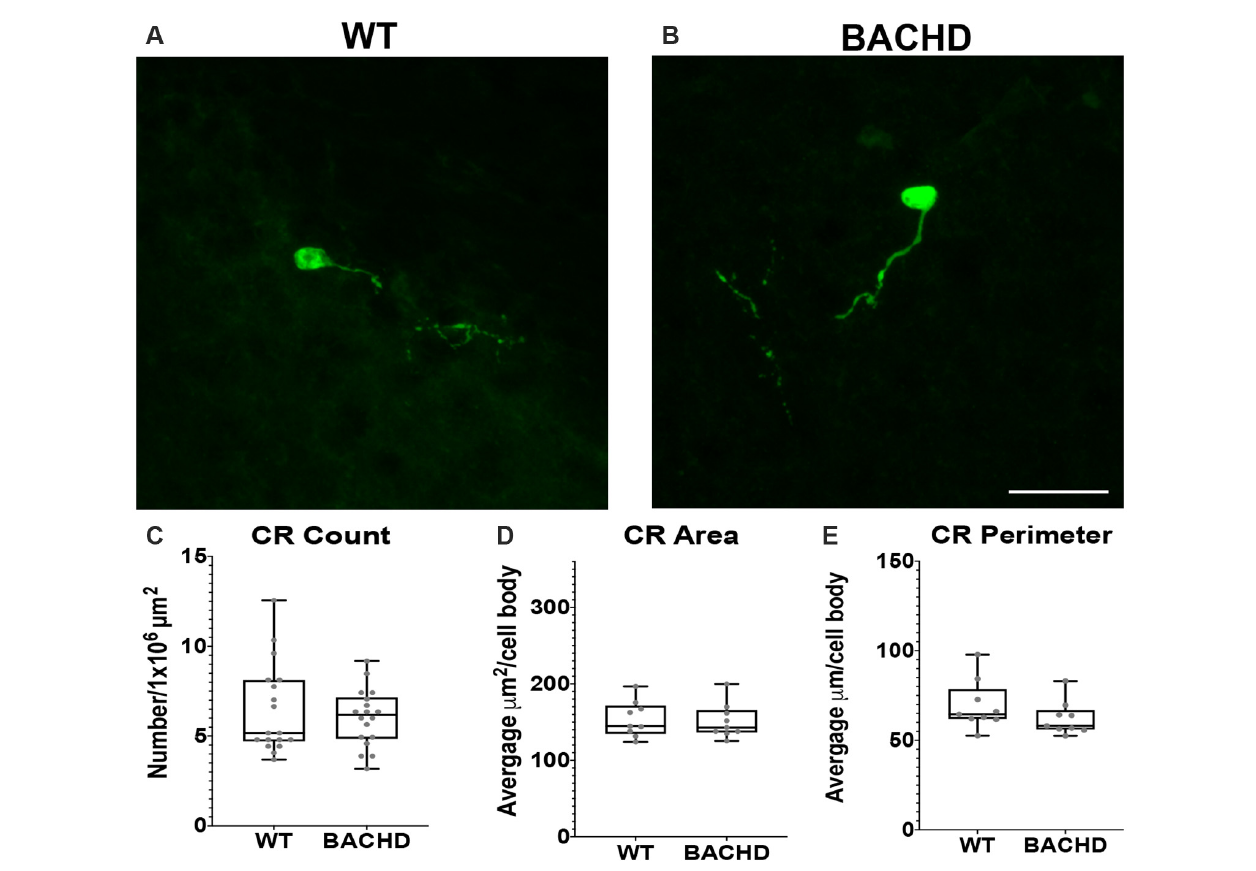
FIGURE 4 | Calretinin (CR+) interneurons are not significantly reduced in BACHD mice at 12–14 months of age. Indirect immunofluorescent staining was performed on WT (A) and BACHD (B) mice to detect CR+ cells. CR+ cell number ( p = 0.9314; C ), area ( p = 0.7304; D ), and perimeter ( p = 0.1903; E ) are presented. The Mann–Whitney test was used for the analyses, and n = 3 WT and n = 3 BACHD. Scale bar is 25 µ m.